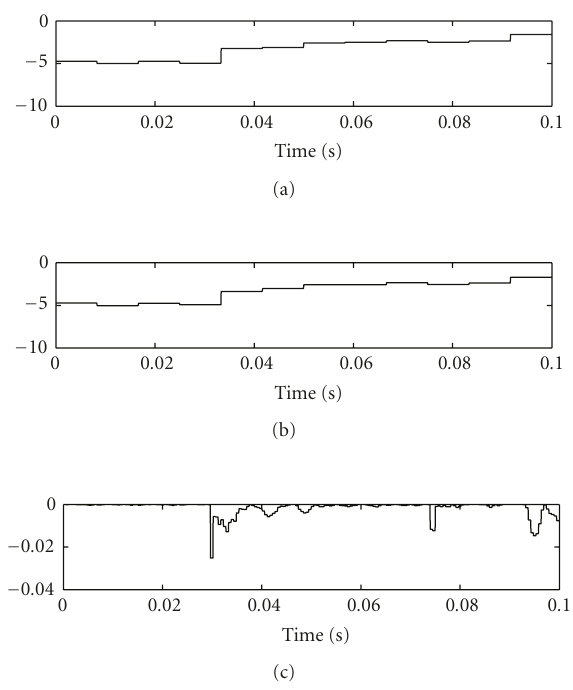
Figure 15: (a) C 4 (0) HOS-based parameter extracted from { x ( n ) } , (b) C 4 (0) HOS-based parameter extracted from { f ( n ) } , (c) C 4 (0) HOS-based parameter extracted from { u ( n ) } .